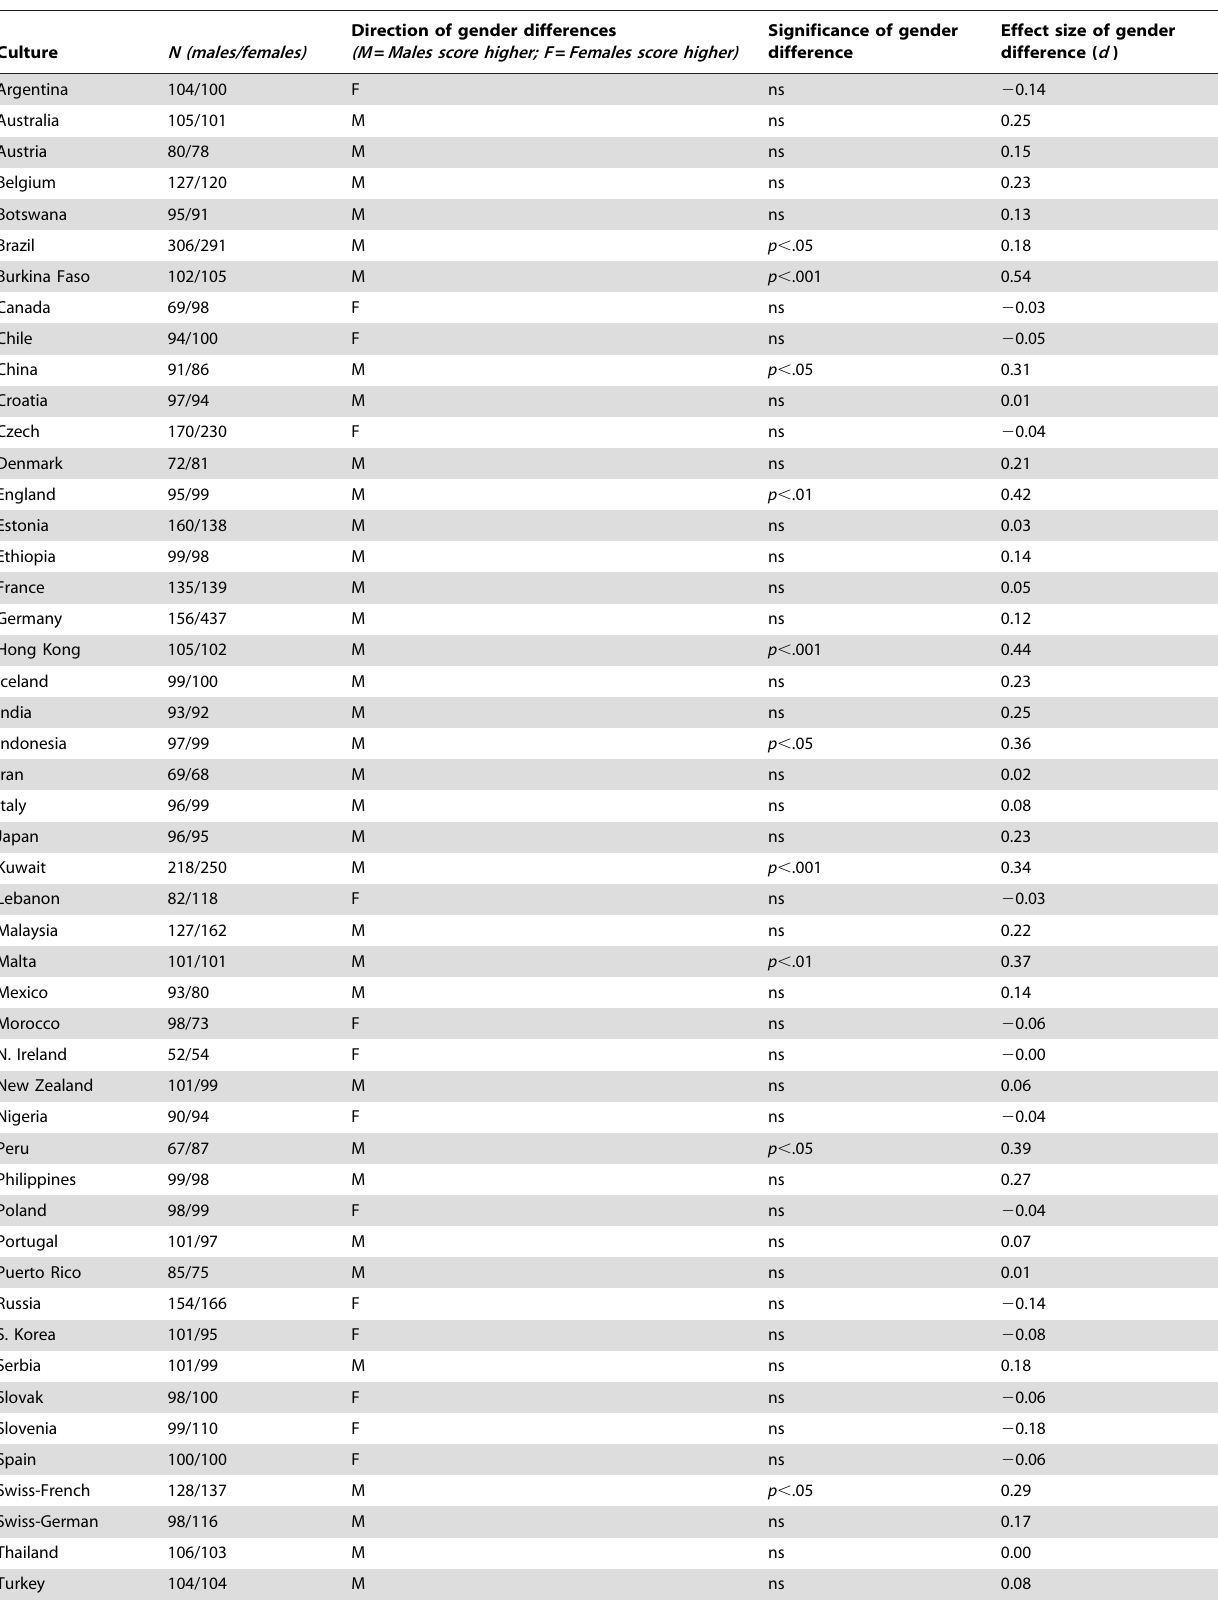
Table 1. Gender Difference in the Entrepreneurship-Prone Big Five Profile Across 51 Cultures.